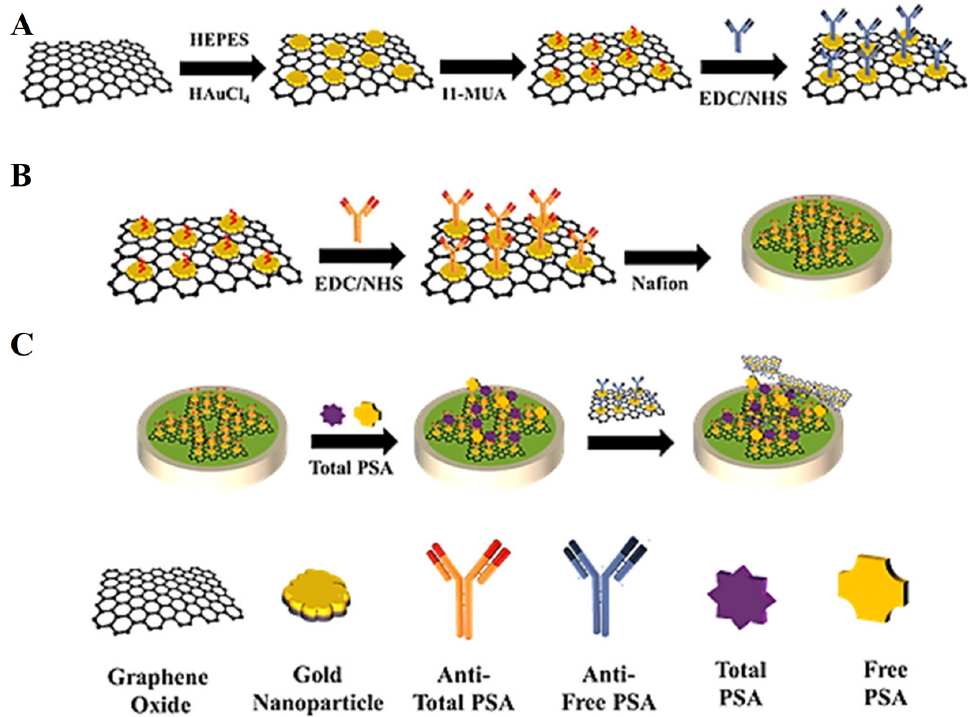
Figure 4. ( A ) Procedures for the fabrication of Go/GNP/Ab. ( B ) Procedure for preparing the electrochemical sensor. ( C ) Schematic illustration of the novel electrochemical sensor for PSA marker detection. Reprinted with permission from Ref. [37] . Copyright 2019, Wiley.